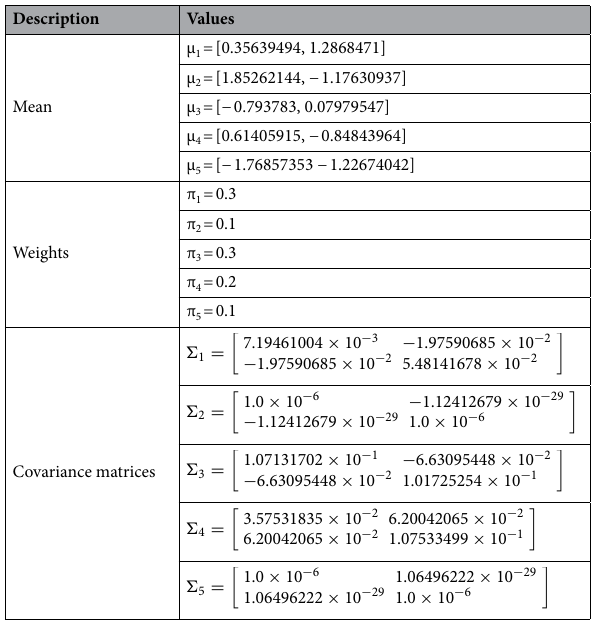
Table 5. GMM parameters for standardized 2 PCs for data of FTIR spectra.